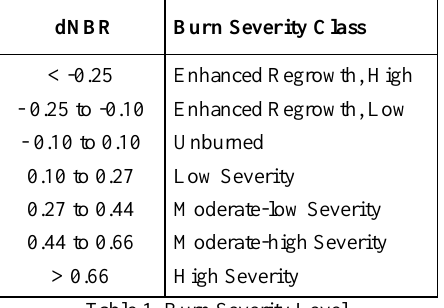
Table 1. Burn Severity